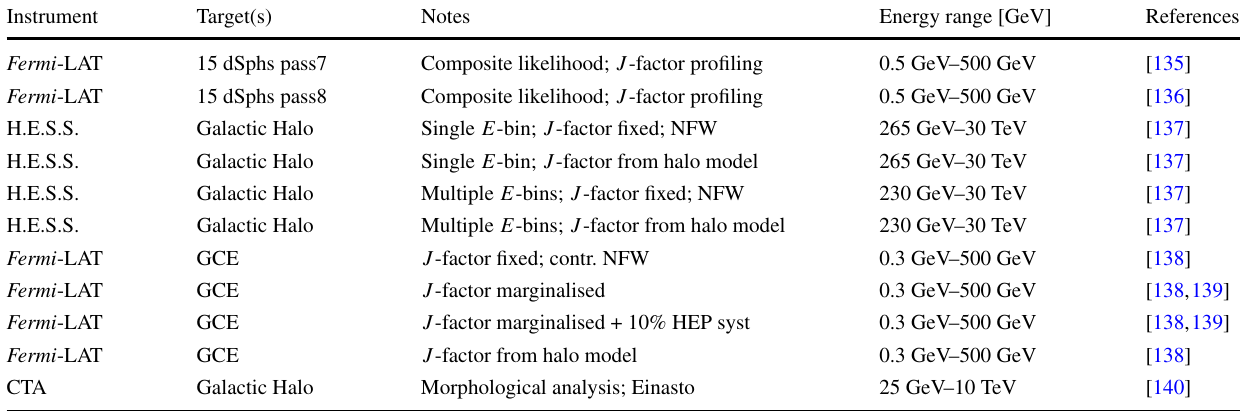
Table 7 Likelihoods and J -factor treatment currently implemented in gamLike , for dwarf spheroidals, the Galactic halo, the Fermi Galactic centre GeV excess (GCE). J -factors are either calculated for the halo model employed in the scan (“ J -factor from halo model”) or derived